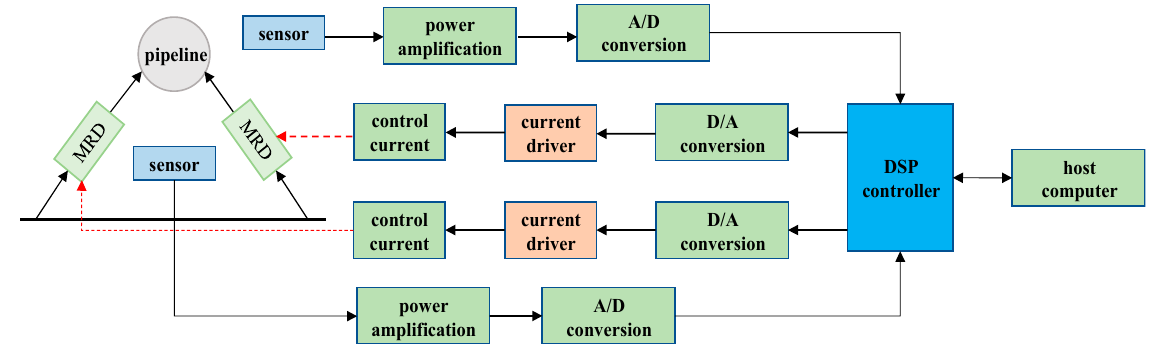
Figure 4. Schematic diagram of MR damping clamp.